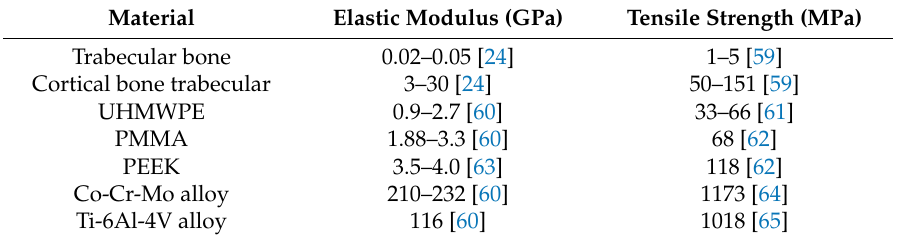
Table 3. Elastic modulus of bone and materials commonly used in the manufacture of